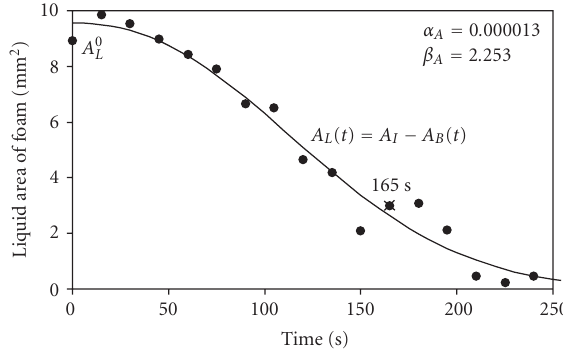
Figure 3.14. Temporal development of the two-dimensional liquid area of the foam pictures according to (3.14). For the marked point at 165 s, see Figure